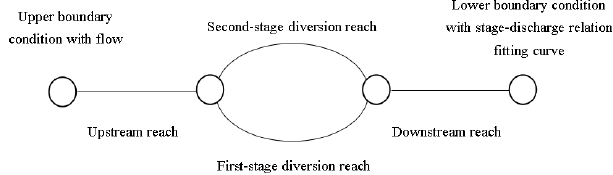
Figure 4. Sketch map of river network in the study area.